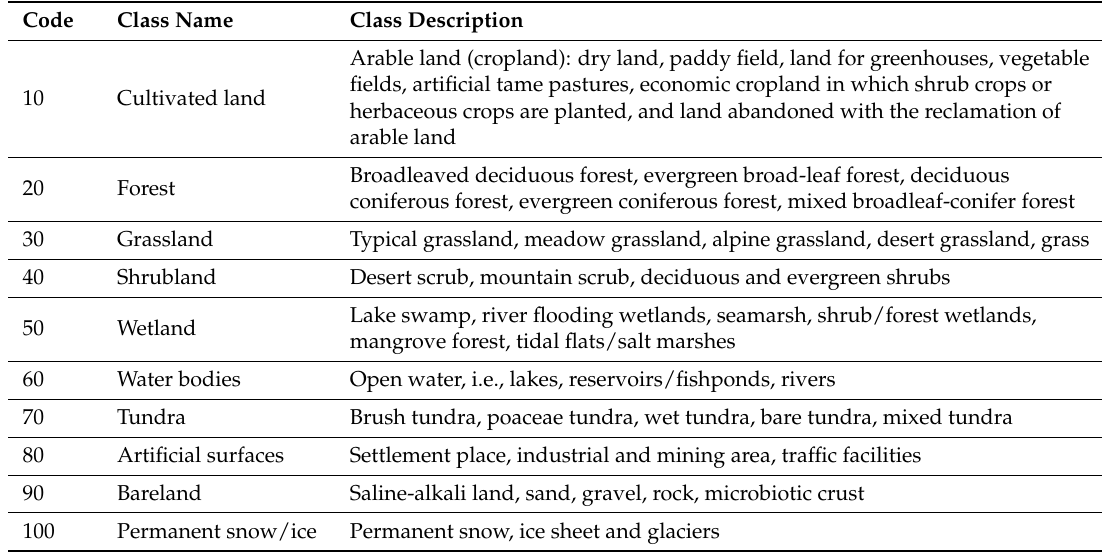
Table 1. The classes in GlobeLand30